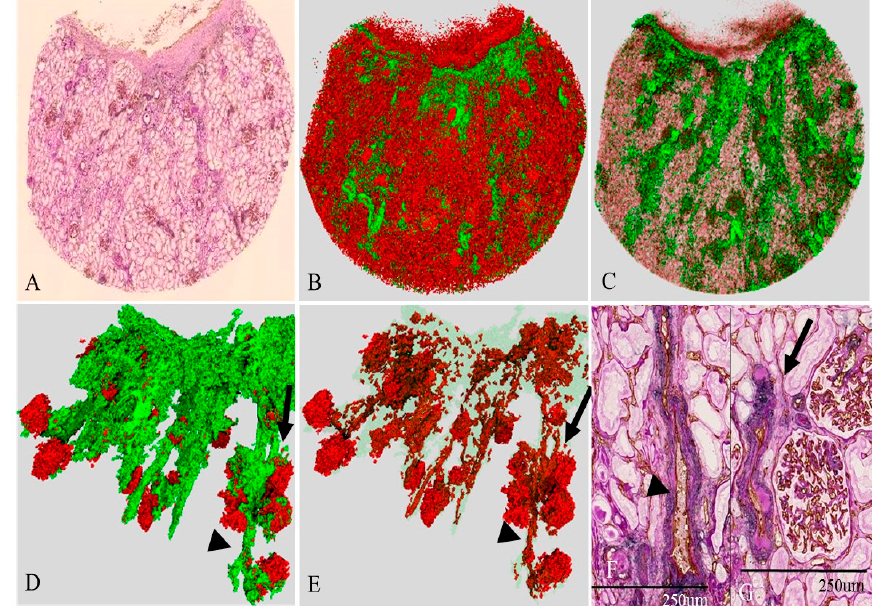
Figure 4. Vascular tree in Nephrosclerosis (Case 4). ( A ) Original 2D image of a section double- immunostained with anti-CD34 ( brown ) and the anti-SMA ( blue ) and then PAS stain; ( B , C ) 3D